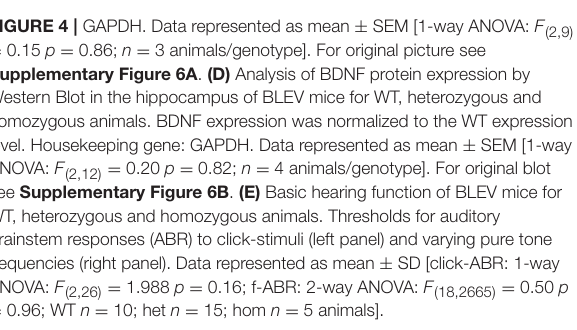
FIGURE 4 | GAPDH. Data represented as mean ± SEM [1-way ANOVA: F (2,9) = 0.15 p = 0.86; n = 3 animals/genotype]. For original picture see Supplementary Figure 6A . (D) Analysis of BDNF protein expression by Western Blot in the hippocampus of BLEV mice for WT, heterozygous and homozygous animals. BDNF expression was normalized to the WT expression level. Housekeeping gene: GAPDH. Data represented as mean ± SEM [1-way ANOVA: F (2,12) = 0.20 p = 0.82; n = 4 animals/genotype]. For original blot see Supplementary Figure 6B . (E) Basic hearing function of BLEV mice for WT, heterozygous and homozygous animals. Thresholds for auditory brainstem responses (ABR) to click-stimuli (left panel) and varying pure tone frequencies (right panel). Data represented as mean ± SD [click-ABR: 1-way ANOVA: F (2,26) = 1.988 p = 0.16; f-ABR: 2-way ANOVA: F (18,2665) = 0.50 p = 0.96; WT n = 10; het n = 15; hom n = 5